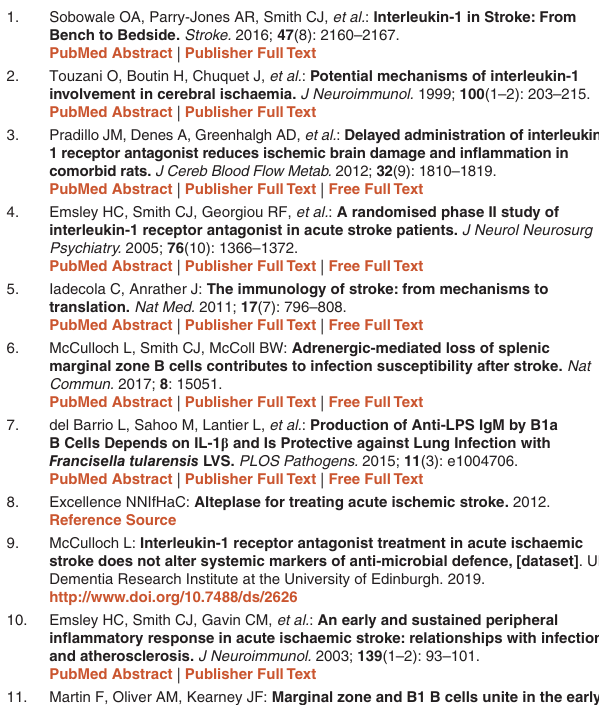
- Supplementary Figure 11.tif (figure showing comple- ment concentration in IL-1ra and placebo treated patients at individual sampling points after stroke) - Data Supplementary Fig 1.xlsx - Data Supplementary Fig 4.xlsx (data underlying Supplementary Figures 1-4) - Data Supplementary Fig 5.xlsx (Supplementary Table 1 in spreadsheet format) - Complement time course data Supplementary